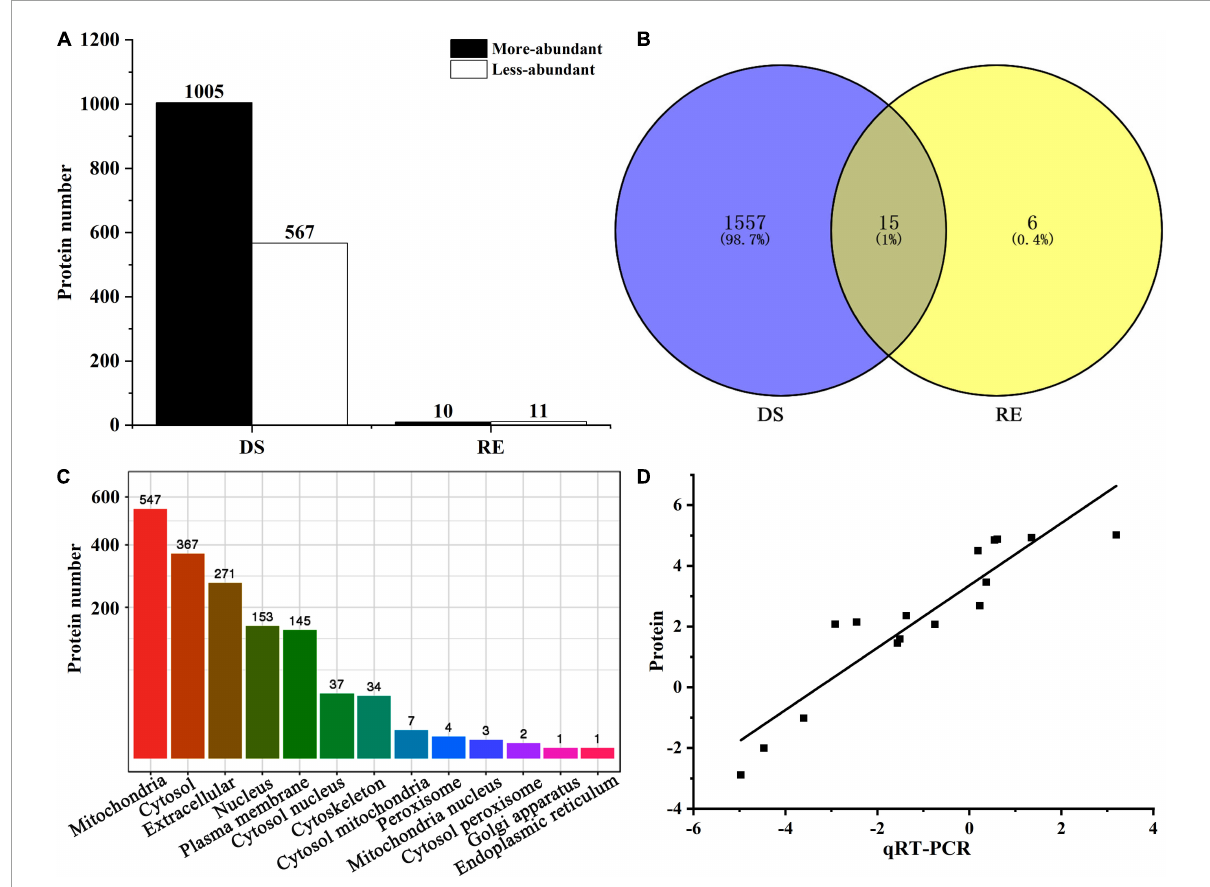
FIGURE2 Number (A) , Venn diagram (B) , subcellular localization (C) , and correlation coefficient of differentially abundant proteins between proteome and qRT-PCR (D) . DS and RE represent dessication-stress and rehydration,